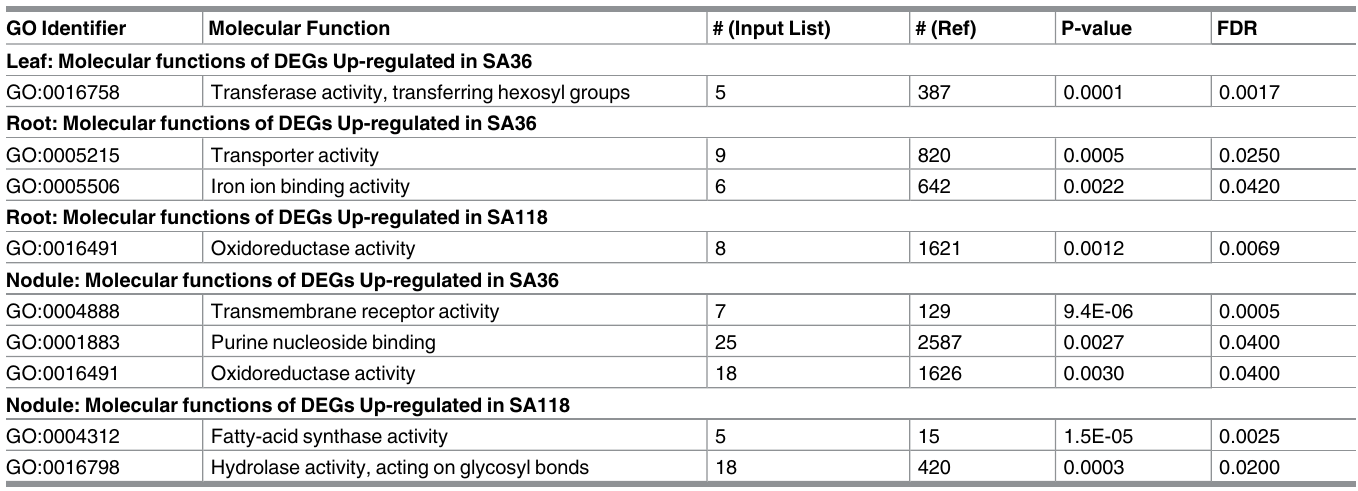
Table 3. Enriched molecular functions of differentially expressedgenes in leaves, roots and nodules between SA36 and SA118. GO